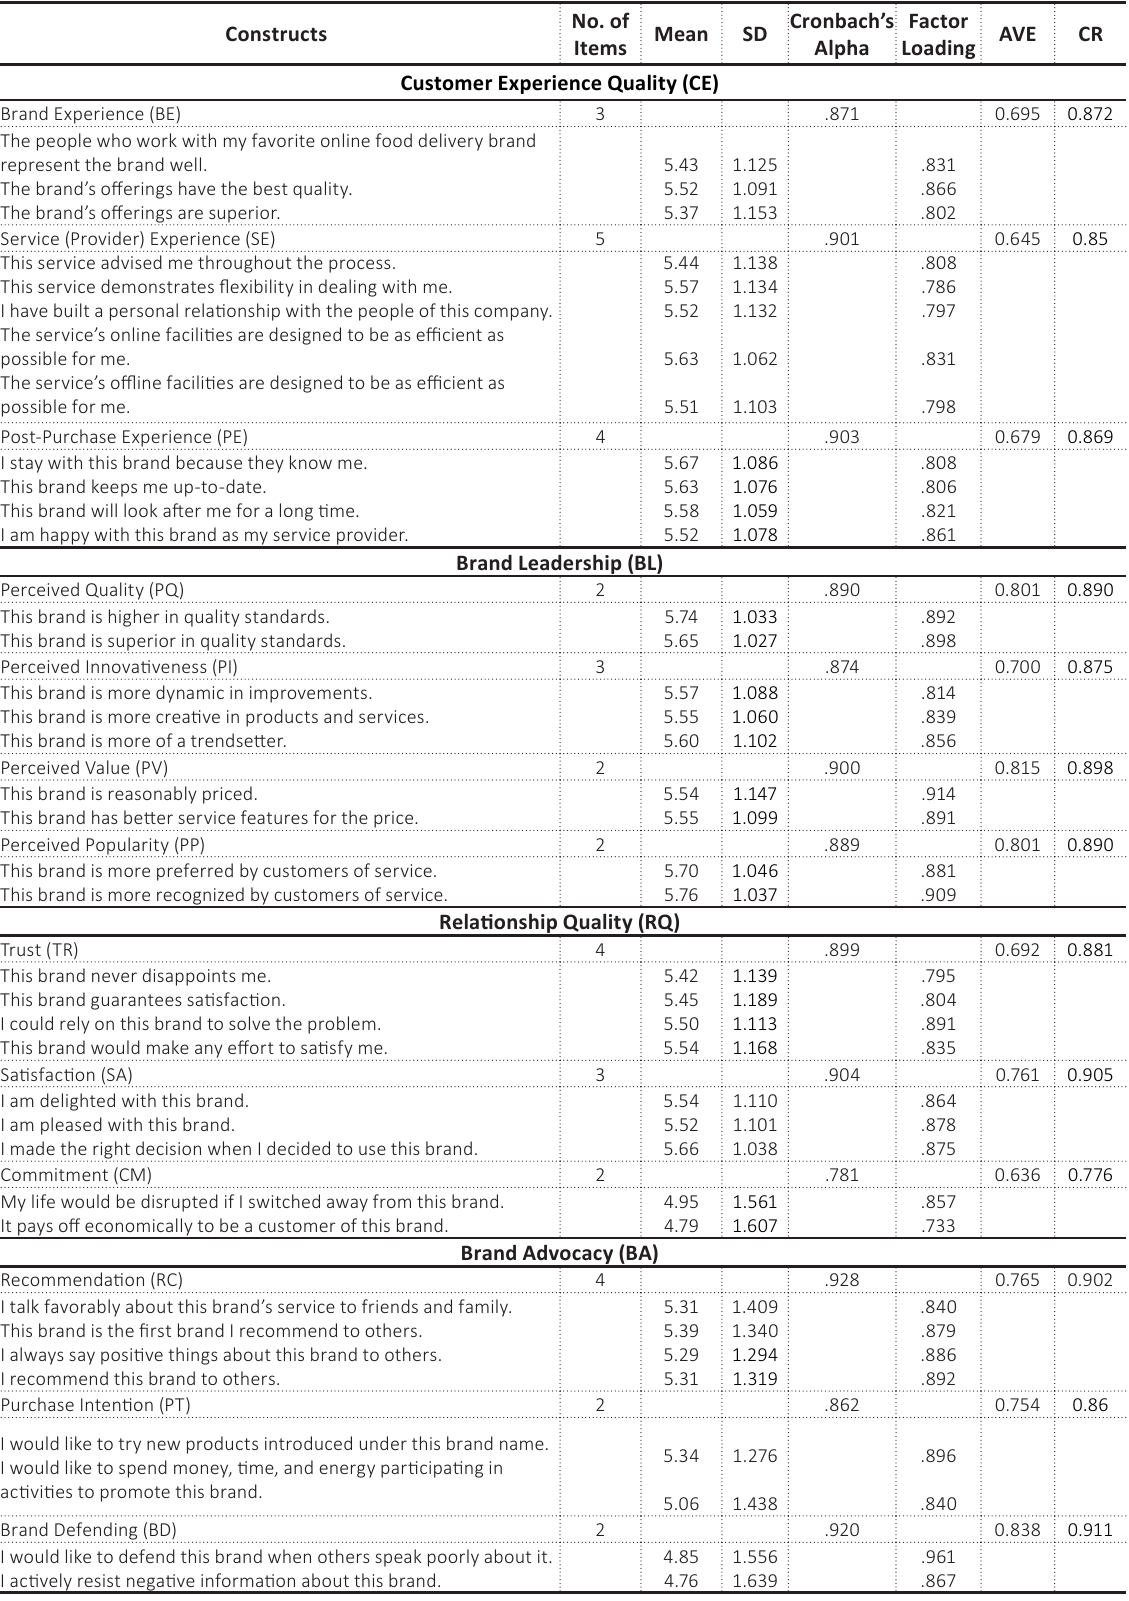
Table A1. Mean, SD, Cronbach’s alpha, CR, AVE, and factor loading